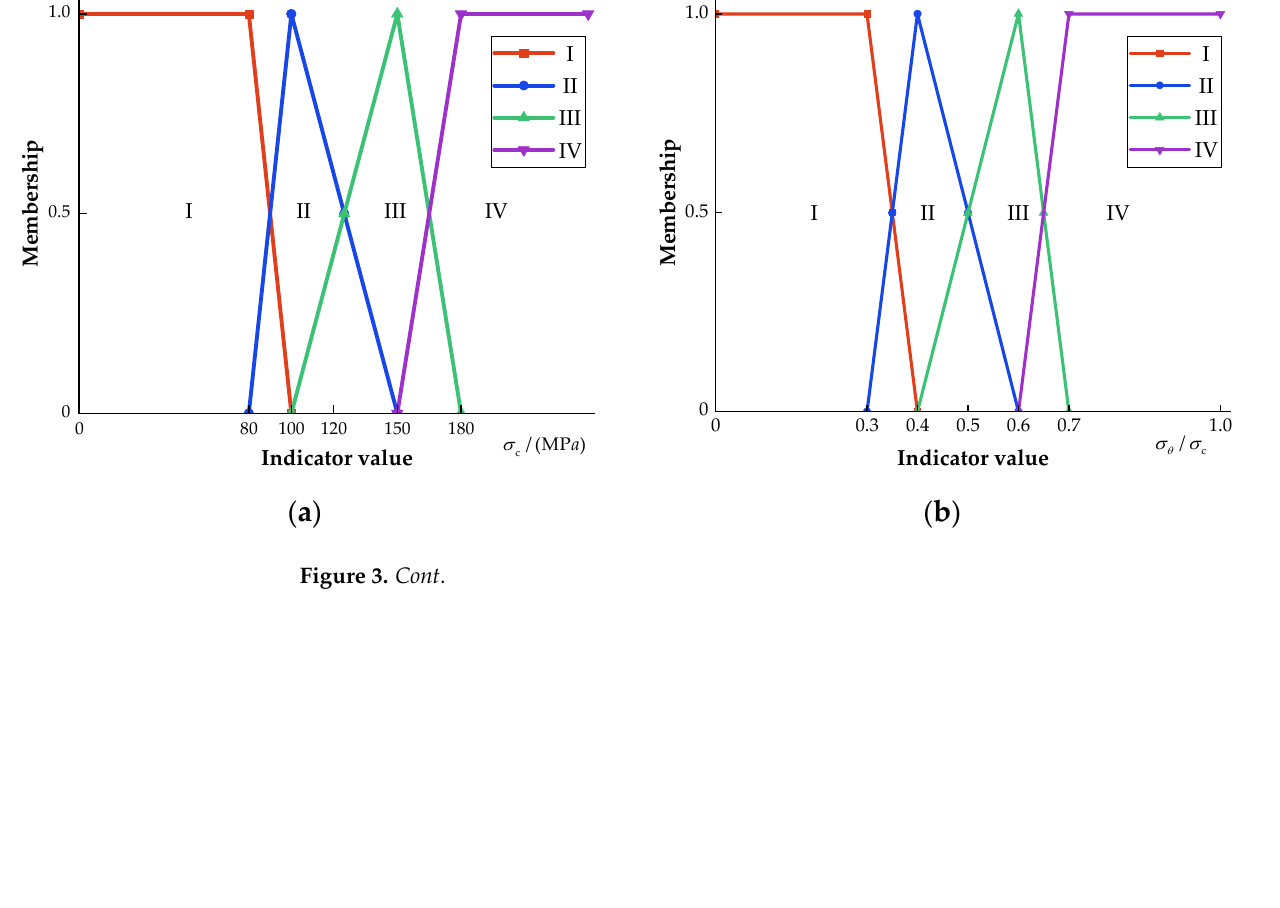
Table 2. Single-indicator classi fi cation standards for rockburst intensity.